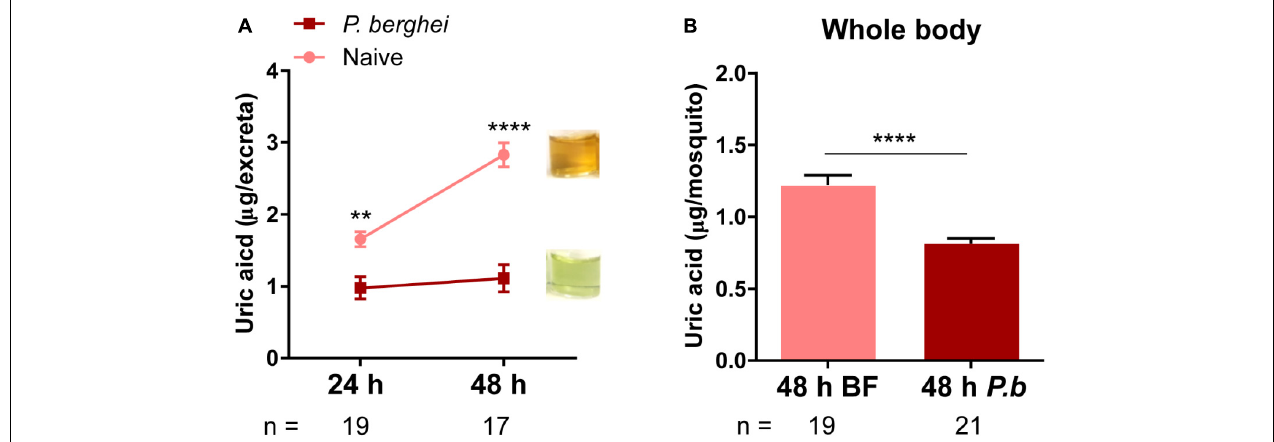
FIGURE 1 | Uric acid levels are reduced in excreta and in whole mosquitoes following Plasmodium infection. Uric acid in the excreta of individual mosquitoes was measured at both 24 and 48 h after blood-feeding (naïve) or P. berghei infection. Plasmodium infection significantly reduced uric acid concentration in excreta when compared to mosquitoes that fed on a naïve blood meal. Inset images display representative images of differences in the intensity of uric acid observed in excreta samples at 48 h-post challenge (A) . Data from excreta samples were analyzed using a two-way repeated-measures ANOVA followed by Sidak’s multiple comparisons. Uric acid levels were similarly measured in whole mosquito samples 48 h after blood-feeding (naïve) or P. berghei infection (B) , where Plasmodium -infected mosquitoes retained less uric acid than those provided with a naïve blood meal. Data were analyzed by an unpaired t -test. Bar graphs represent mean ± SEM of three independent experiments. Asterisks denote significance (** P < 0.01, **** P < 0.0001). n, number of individual mosquitoes examined. Data analysis was performed using GraphPad Prism 7.